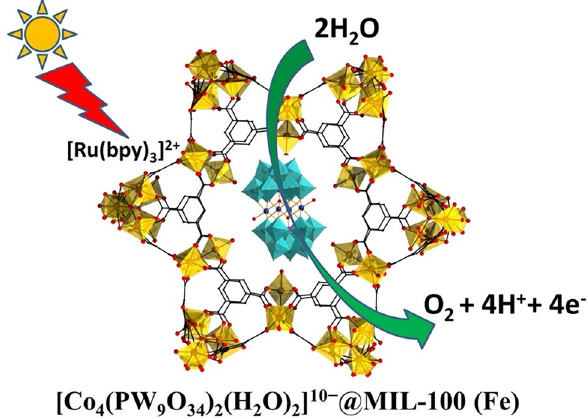
Figure 11: A schematic representation showing encapsulation of cobalt-based POMs in the cavities of iron-based PMOF (MIL-100) for photocatalytic OER process. Adopted with permission from ref.